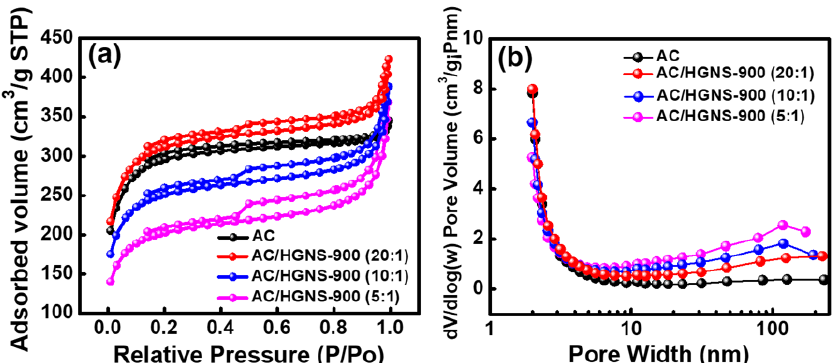
Figure 5. ( a ) N2 adsorption / desorption isotherms and ( b ) pore size distribution data of various electrode Figure 5. ( a ) N 2 adsorption/desorption isotherms and ( b ) pore size distribution data of coating various electrode coating layers.